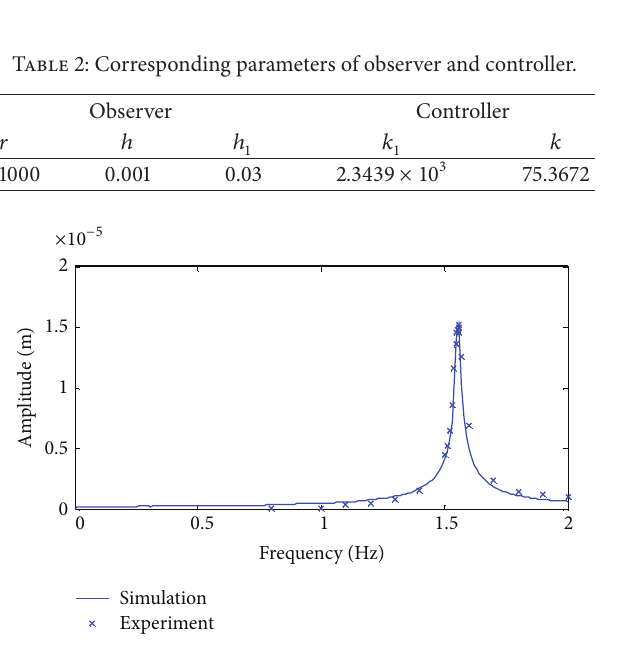
Figure 2: Amplitude-frequency